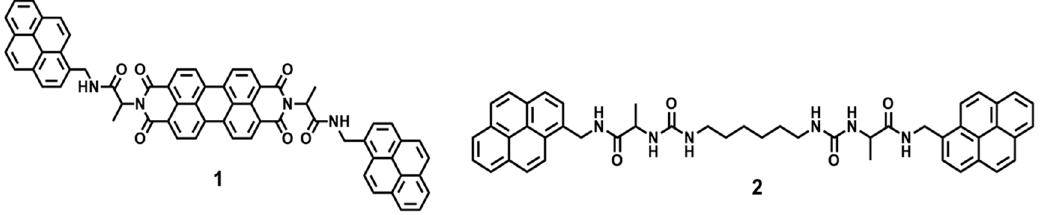
Figure 1. Chemical structures of compounds 1 and 2 .